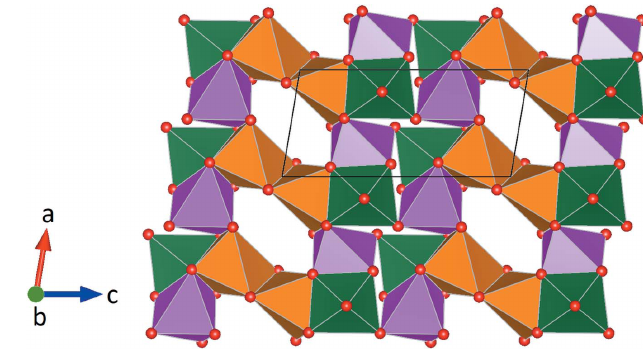
Figure 4 Layer-like structure of [CaO 6 ] octahedra along [010] (Ca1 in green, Ca2 in orange, Ca3 in pink). Octahedra are linked via common corners (Ca1– Ca3), edges (Ca2–Ca2 and Ca2–Ca3) and faces (Ca1–Ca2 and